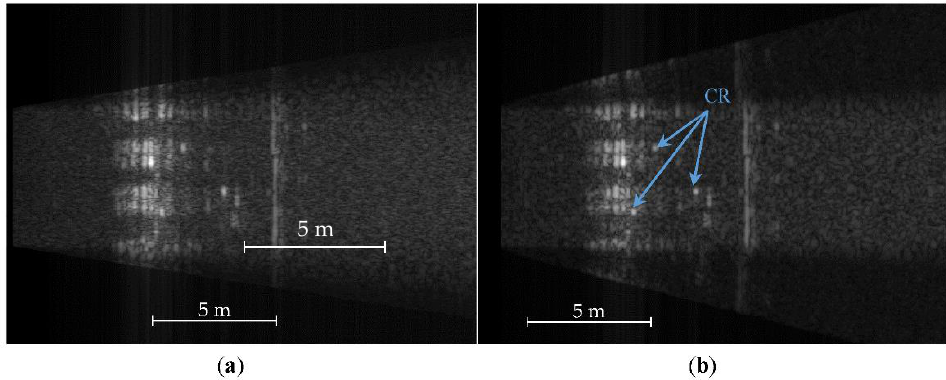
Figure 5. Bistatic GB-SAR focused image by ( a ) range-Doppler algorithm (RDA) and ( b ) back- projection algorithm (BPA) for B = 0.27 m. CR represents trihedral corner reflector.